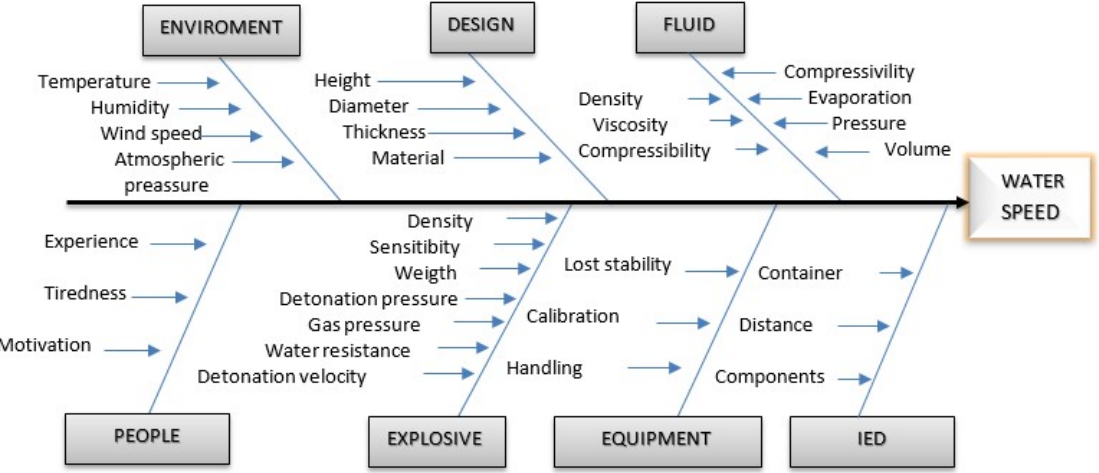
Figure 3. Ishikawa diagram of factors that influence the case study.